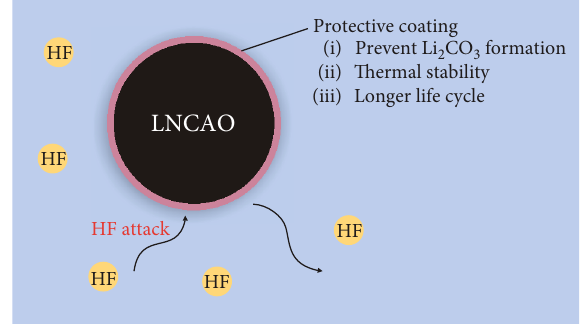
Figure 1: Possible function mechanism of NCA material surface coated by